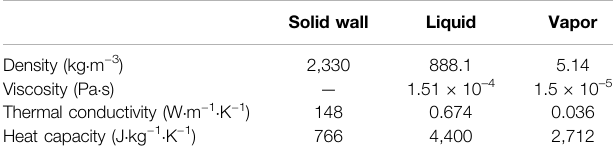
TABLE 1 | Physical properties of the solid wall and the working fl